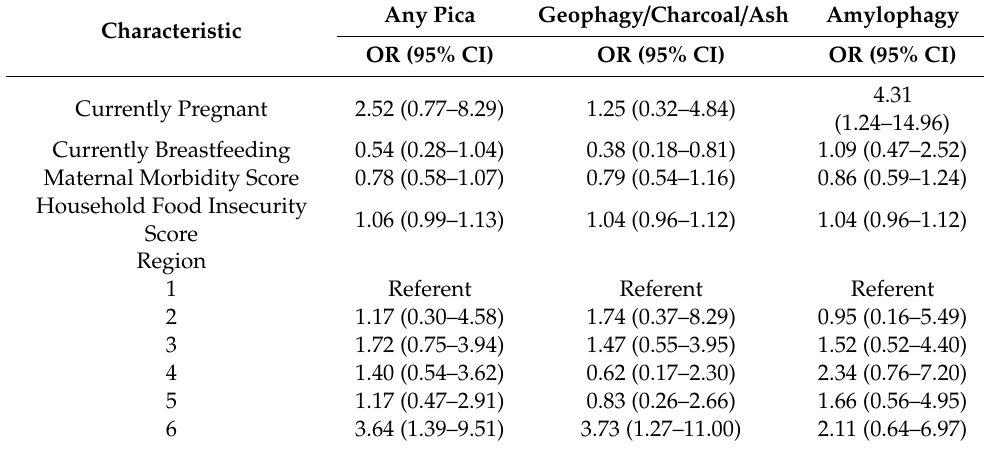
Table 2. Correlates of any pica, geophagy / charcoal / ash, and amylophagy, Mfangano Island, Kenya ( n = 299)